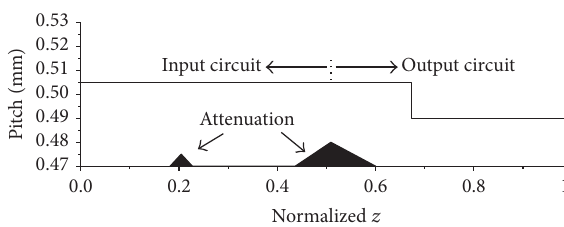
Figure 5: Pitch and attenuation profiles in helix TWT (black and